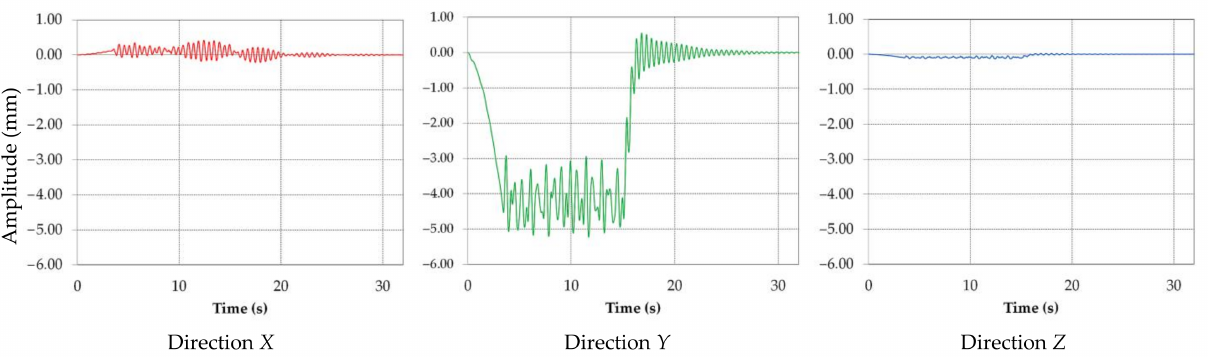
Figure 21. Acceleration for direction X , Y and Z resulting from the time response analysis.